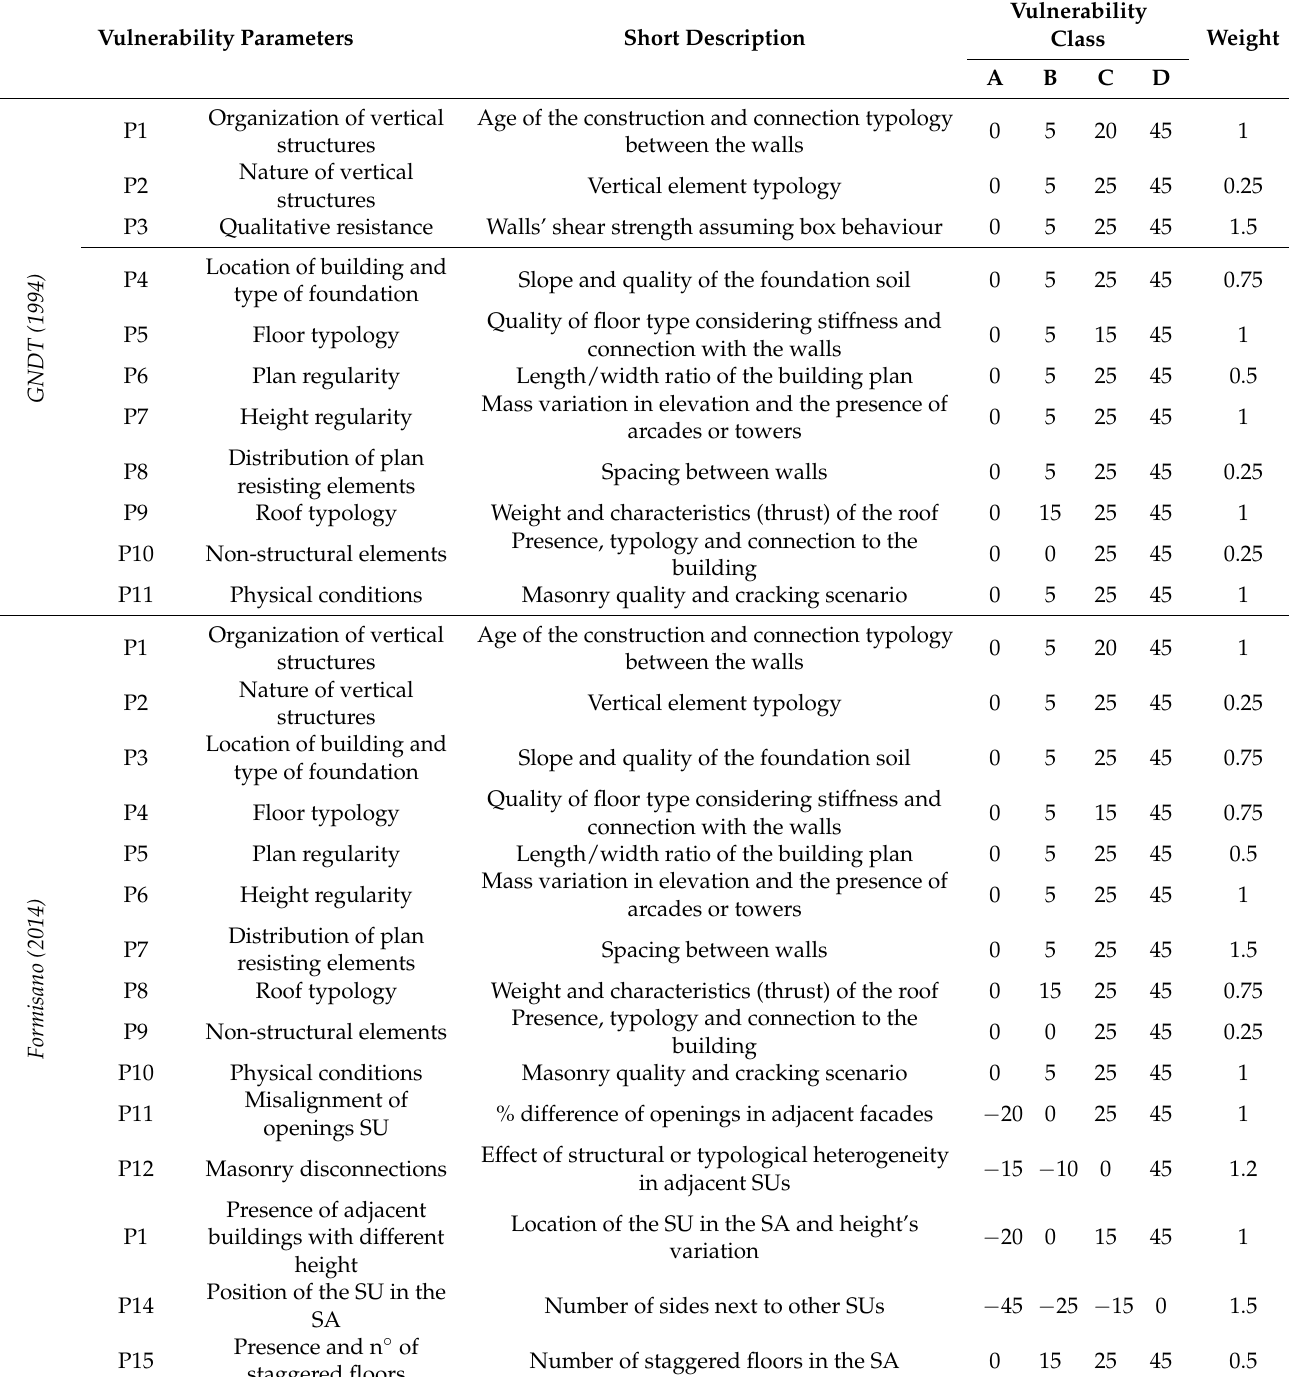
Table 5. Summary table of vulnerability parameters adopted by the different methods.